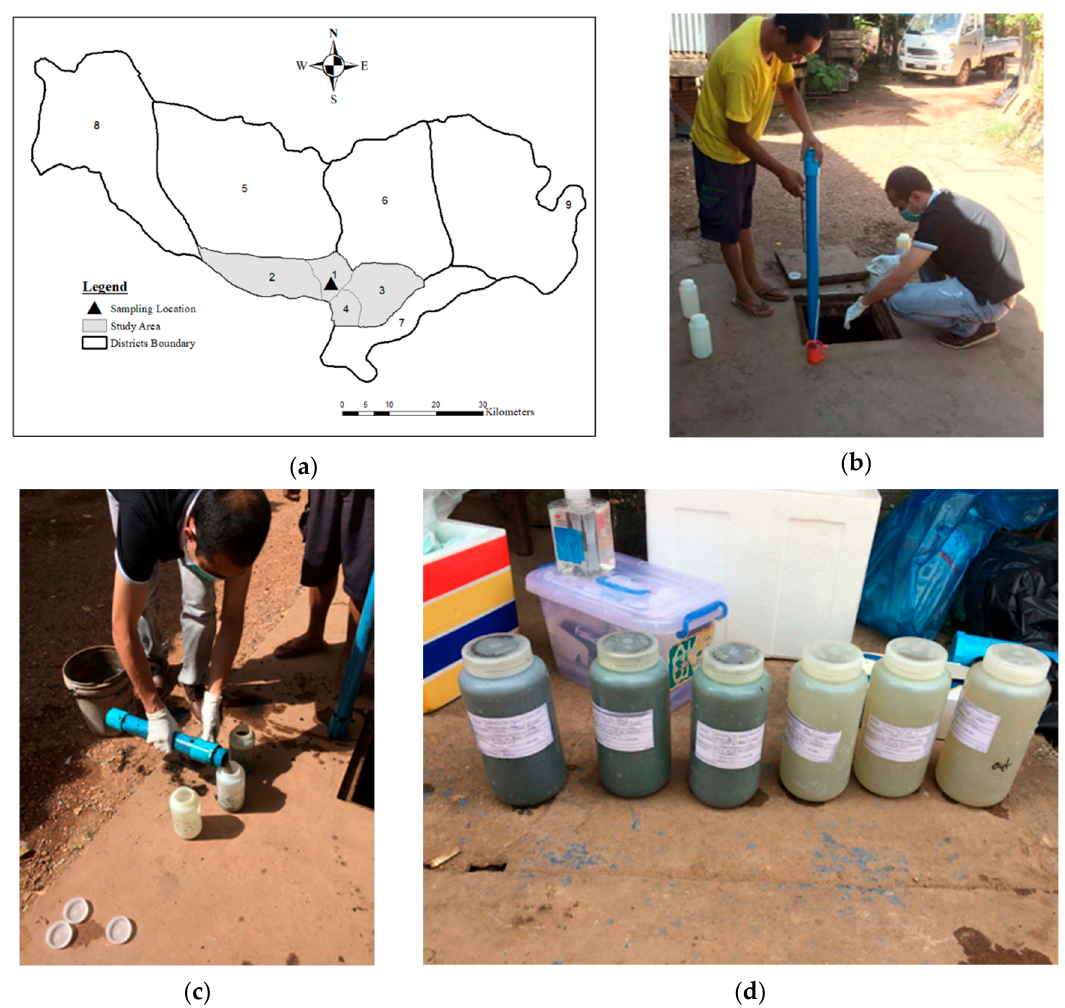
Figure 2. ( a ) Sampling location of a decentralized wastewater treatment plant (WWTP) in Vientiane, ( b ) and ( c ) sampling photos, and ( d ) the influent and effluent samples.